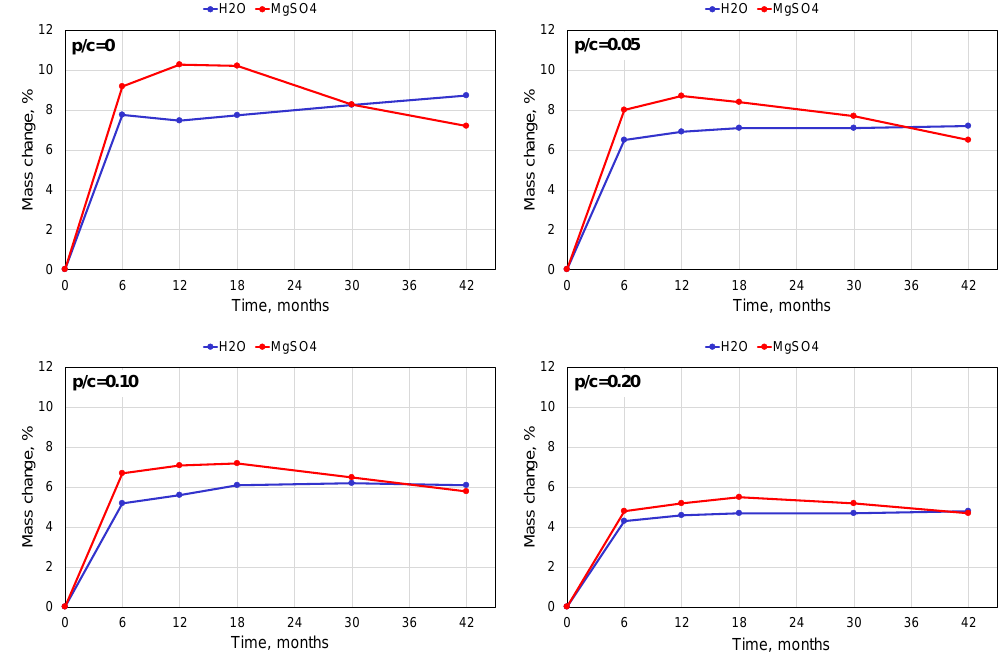
Figure 3. Mass changes of mortar specimens exposed to the 5% MgSO 4 solution and distilled water.